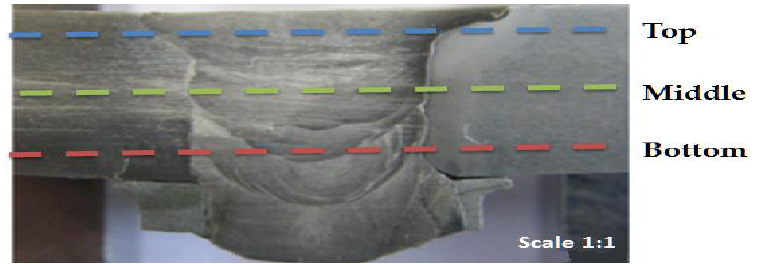
Figure 7. Three positions across the cross section of dissimilar material welded joint for hardness distribution measurements.